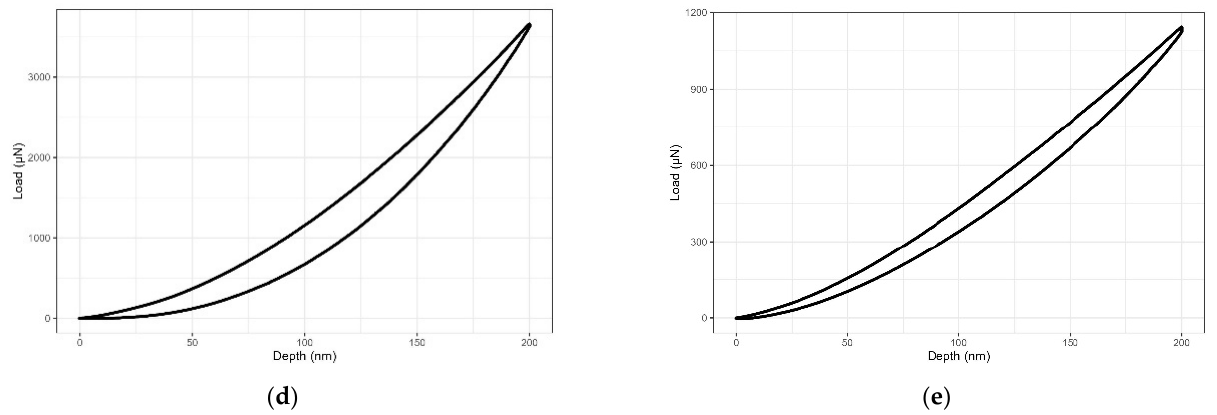
Figure 2. ( a ) Nanoindentation software environment and the mapping grid 10 × 10 used to characterize each specimen, ( b – e ) representative load–displacement nanoindentation curves.